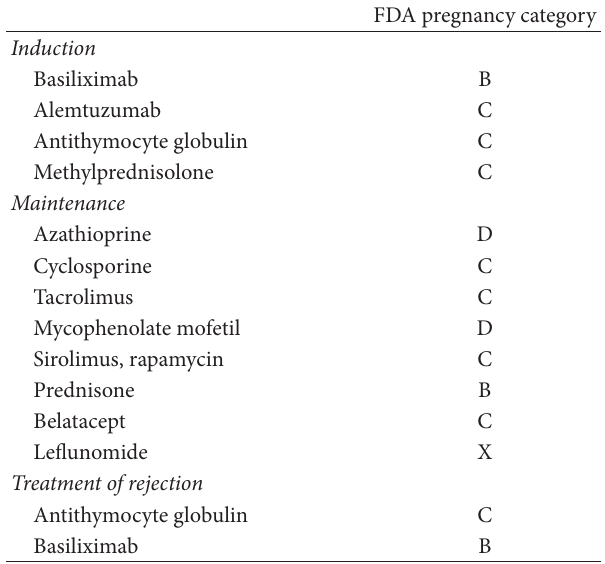
Table 1: Common immunosuppressive drugs use in transplanta-